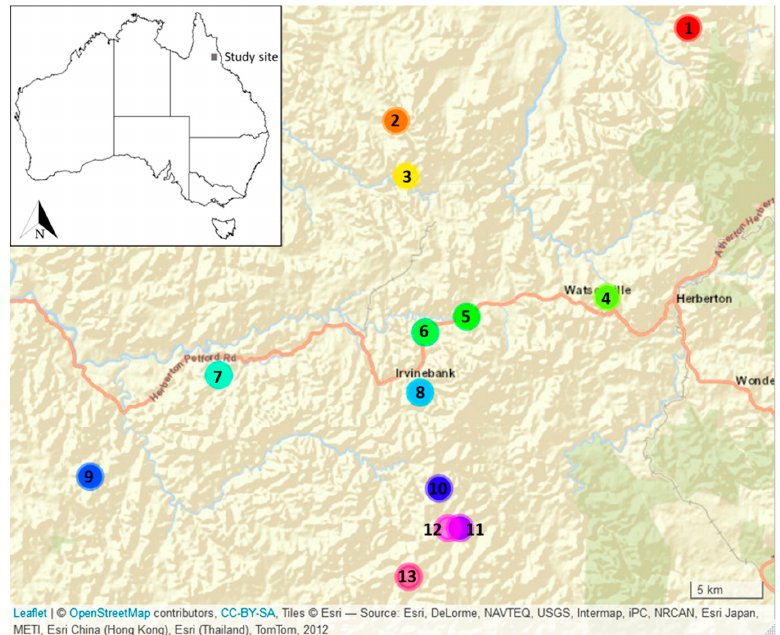
Figure 1. The location of the field sites for Acacia purpureopetala in far North Queensland, Australia. The map was produced in R using Leaflet [29] with an Esri World Street base layer. The numbering of sites following a North to South latitudinal change with site 1 = Springmount, 2 = Stannary Hill North, 3 = Stannary Hill South, 4 = Baal Gammon, 5 = Jumna, 6 = Dargo, 7 = Emuford, 8 = Ibis Dam, 9 -= Gurrumba, 10 = Mt Misery North, 11 = Mt Misery East, 12 = Mt Misery Central and 13 = Mt Misery South.